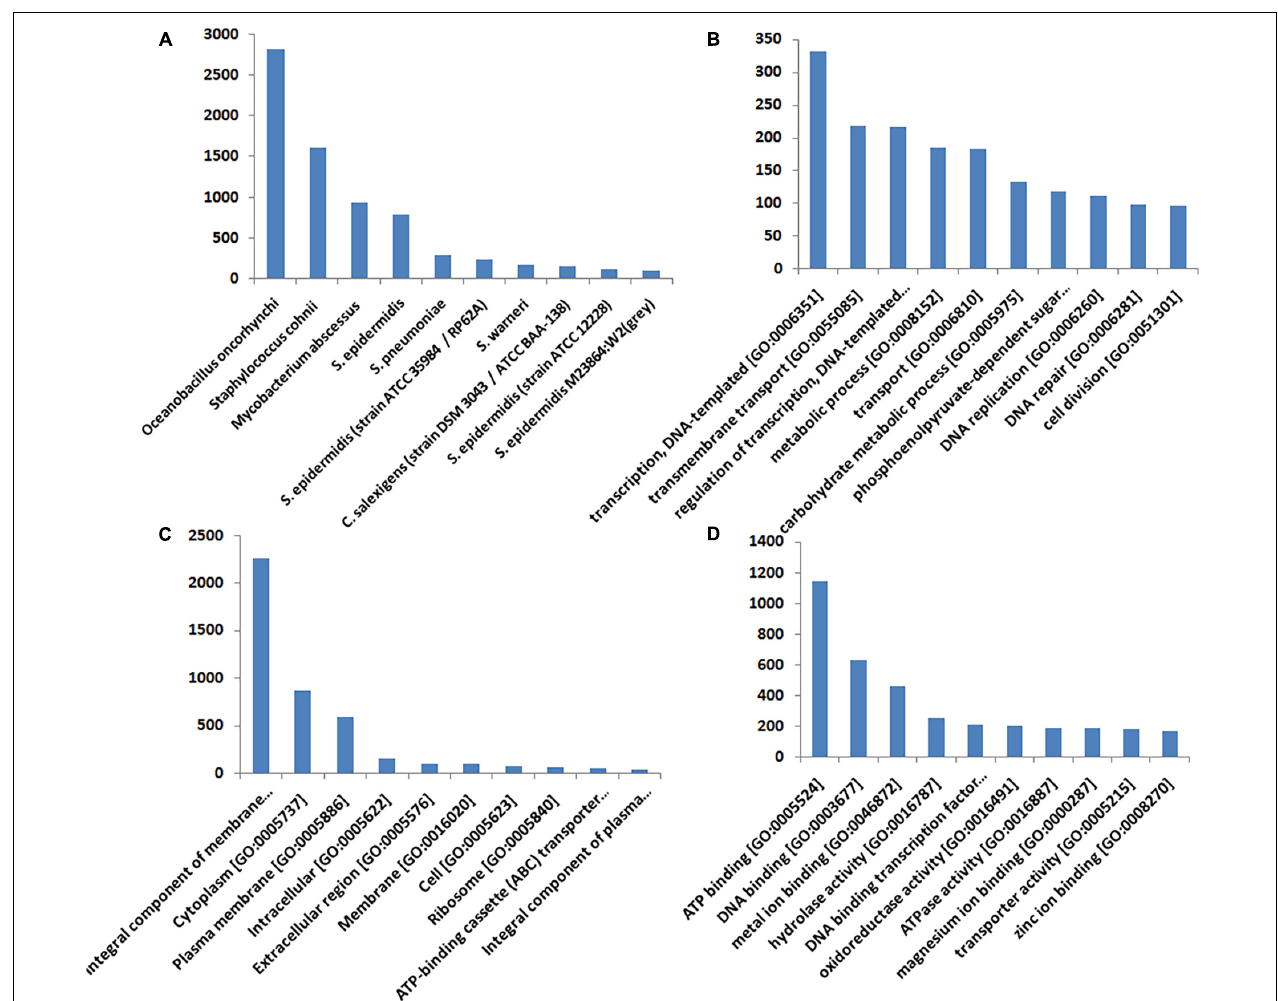
FIGURE 4 | Annotation and the gene ontology of DEGs. The assembled transcripts were compared with the UniProt database using the BLASTX program with an E -value cutoff of 10 - 3 . The best BLASTX hit based on query coverage, identity, similarity score, and description of each transcript was filtered out using an in-house pipeline. Based on the BLASTX summary and E -value and similarity score distribution of BLASTX hits, the annotation was done. (A) Shows the distribution of the top 10 organisms corresponding to the best BLASTX hits. (B–D) Represent the top 10 categories of each gene ontology (GO) in terms of molecular function, cellular component, and biological process, respectively. The transcripts were also mapped against the latest GO